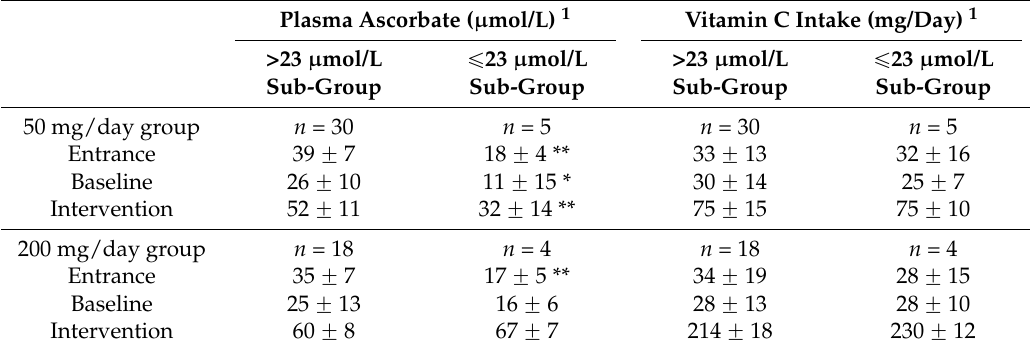
1 Data represent mean ˘ SD. Vitamin C was derived from either vitamin C tablets or the equivalent dose from kiwifruit; * p < 0.05 and ** p < 0.001 as determined by unpaired Student’s t -test of >23 µ mol/L sub-group compared with ď 23 µ mol/L